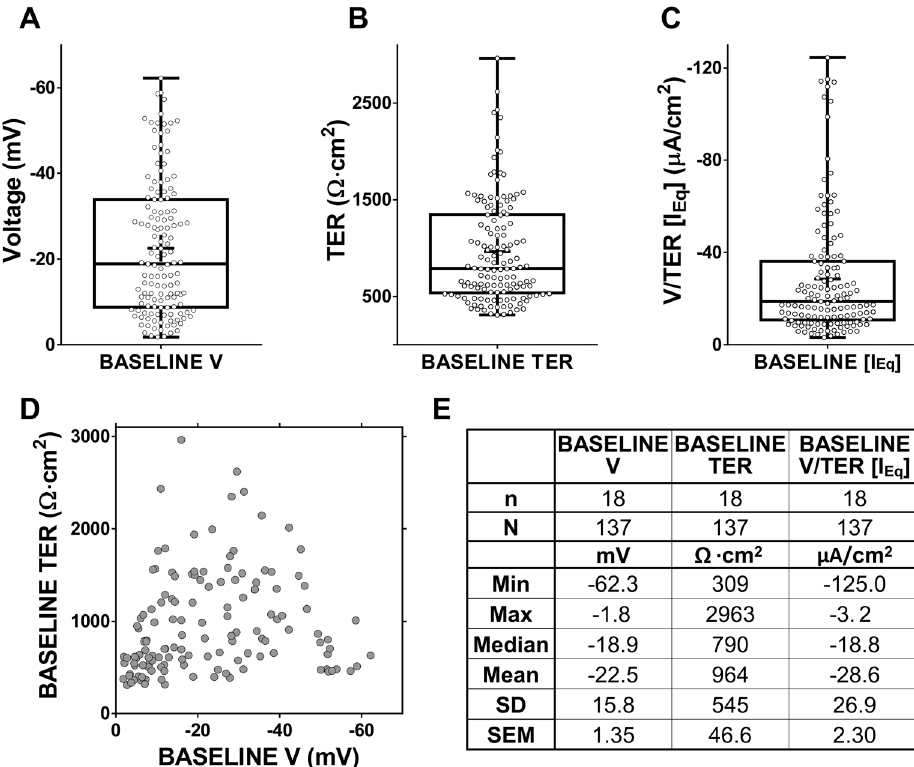
Fig 2. Baseline electrophysiological values from Ussing chamber experiments. (A-C). Box plots showing baseline electrophysiological values. Minimum, maximum (whiskers) and 25 th /75 th percentile, median (box line) and mean (cross) are highlighted. (D) Plot of initial V against TER. (E) Table of basic statistical analysis of the data shown in